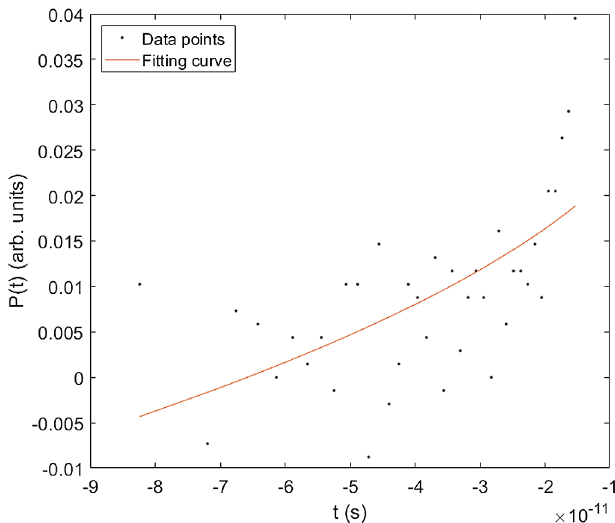
FIG. 20. Time response measurement results of the bulk GaAs cathode at laser wavelength of 520 nm in the interval from − 100 ps to − 10 ps (dots). The solid line shows the fitting curve obtained by the least squares method using the model function. The area under the fitting curve is about 1.5% of the total area of the longitudinal beam